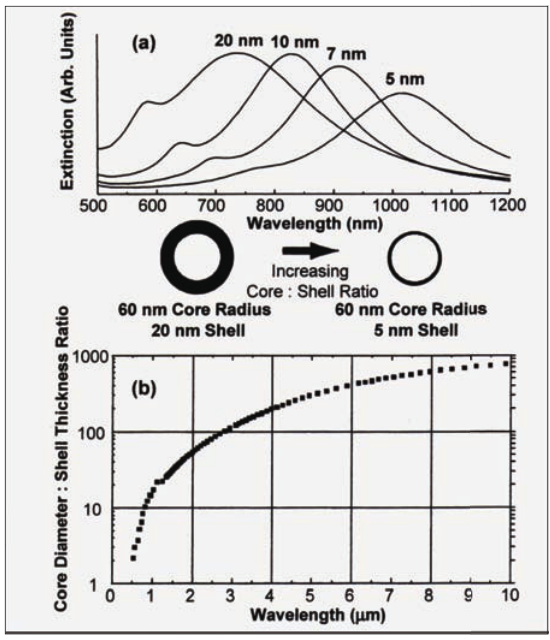
Fig. 15 (a) Theoretically calculated optical resonance of metal nanoshells over a range of core ra- dius/shell thickenss ratios, (b) calculation of optical resonance wavelength versus core ra- dius/shell thickness ratio for metal nanoshells (SiO core, Au shell) 1) 2